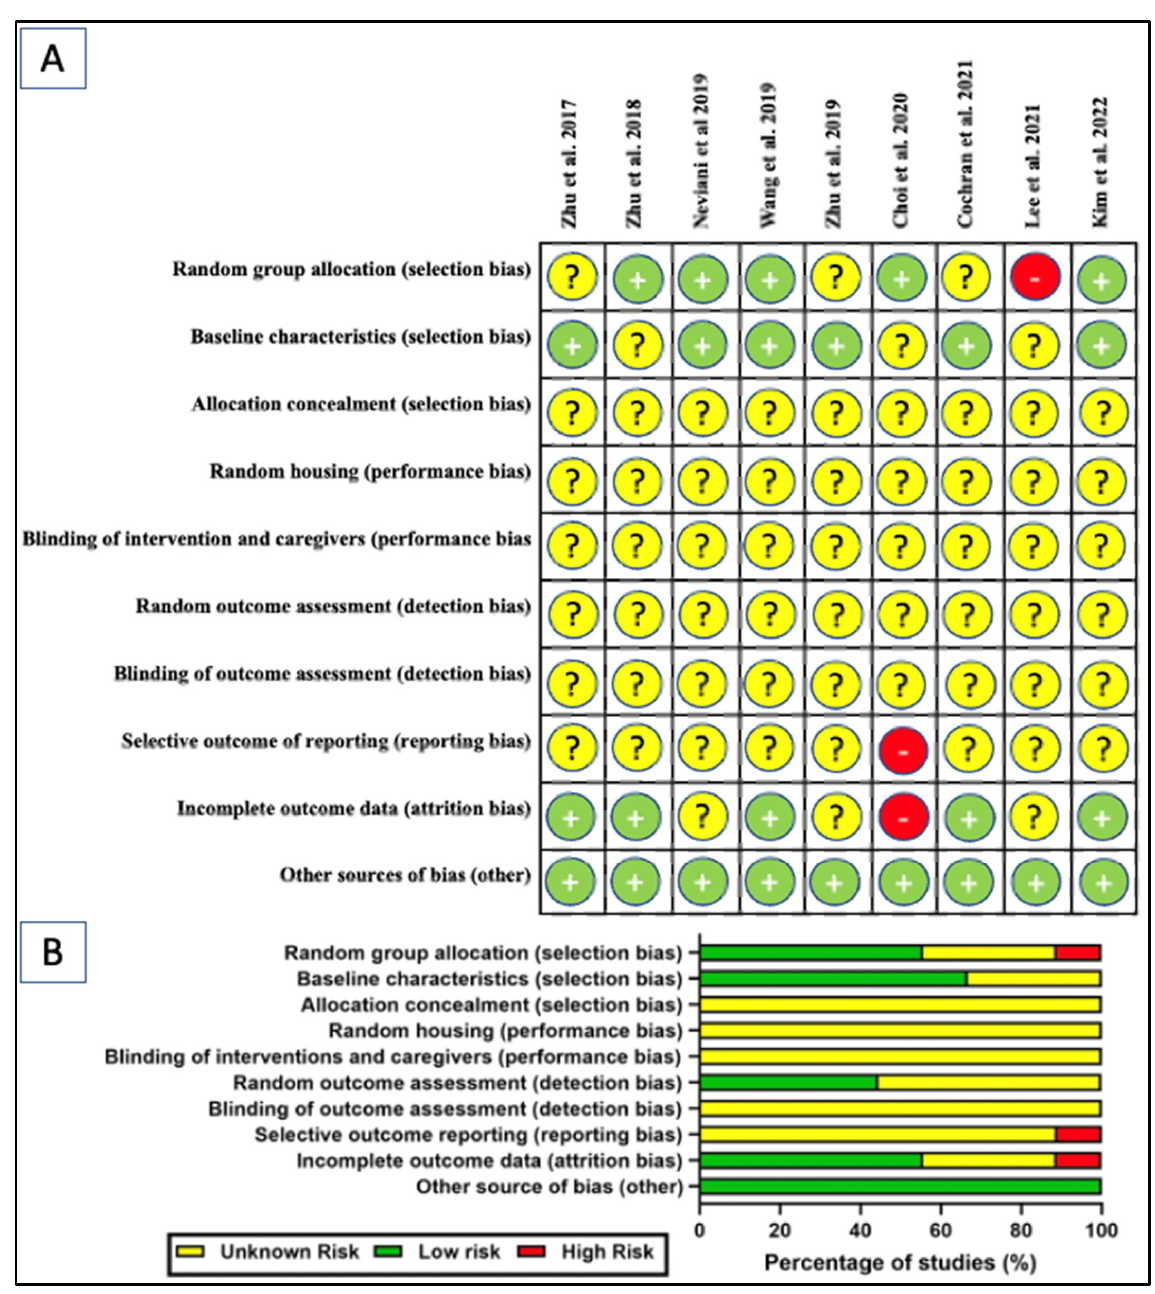
Figure 5. SYRCLE’s risk of bias tool: ( A ) scoring of individual studies; ( B ) overall scores presented as percentage of studies for in-vivo studies [45–47,49,50,53,60,90]. Symbols: yellow “?” indicates unclear risk; green “+” indicates low risk; and red “-” indicates high risk of bias.